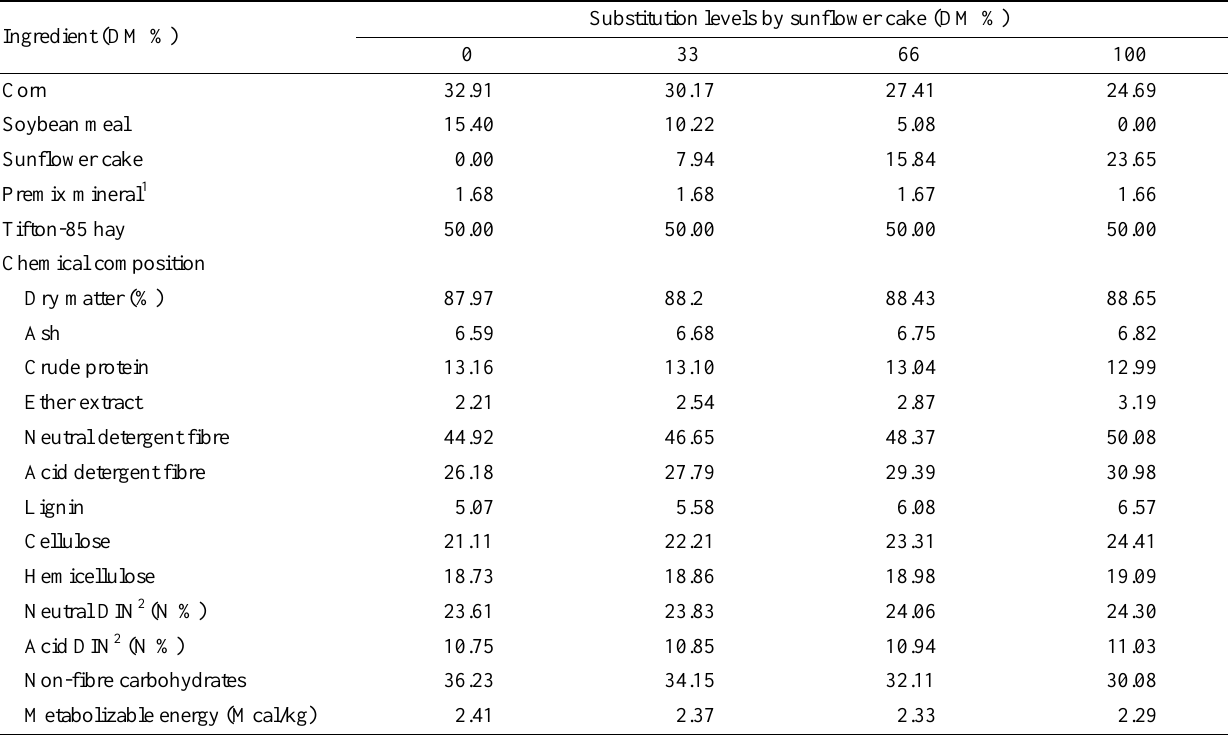
Table 2. Proportion of ingredients and chemical composition of experimental diets fed to 1/2 Boer kids Ingredient (DM